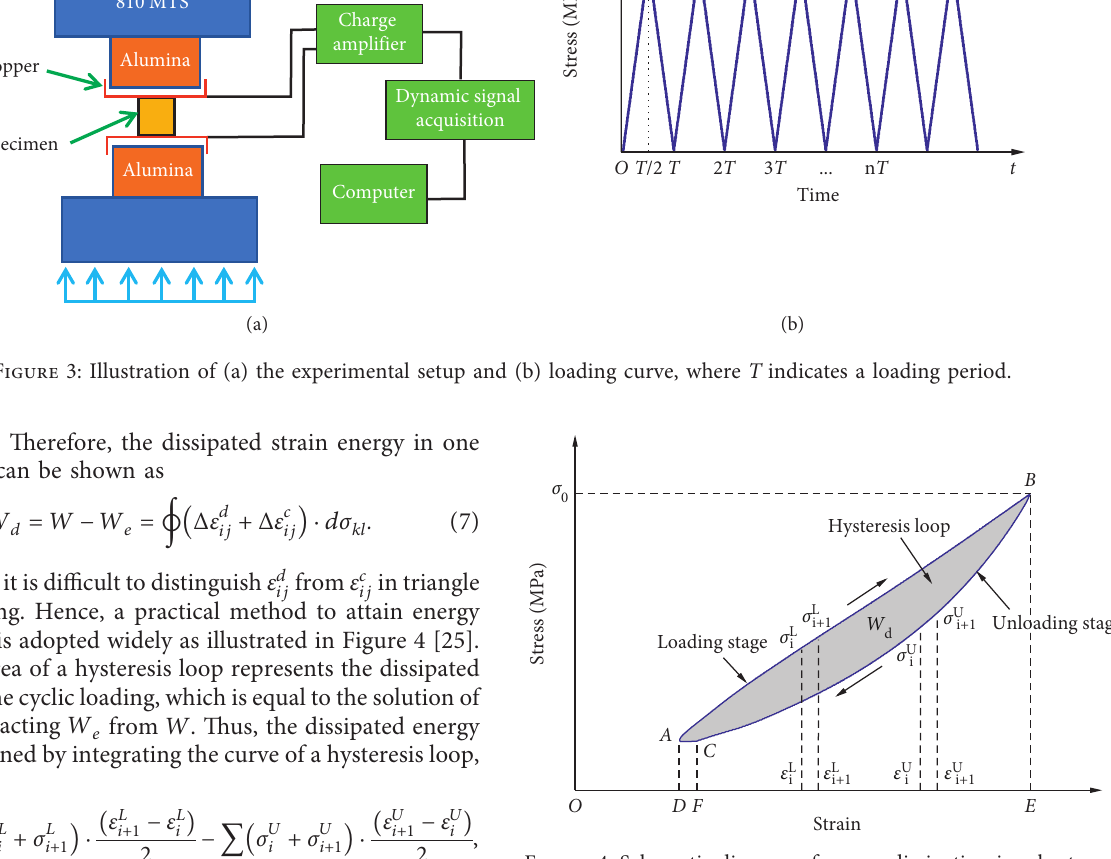
Figure 4: Schematic diagram of energy dissipation in a hysteresis